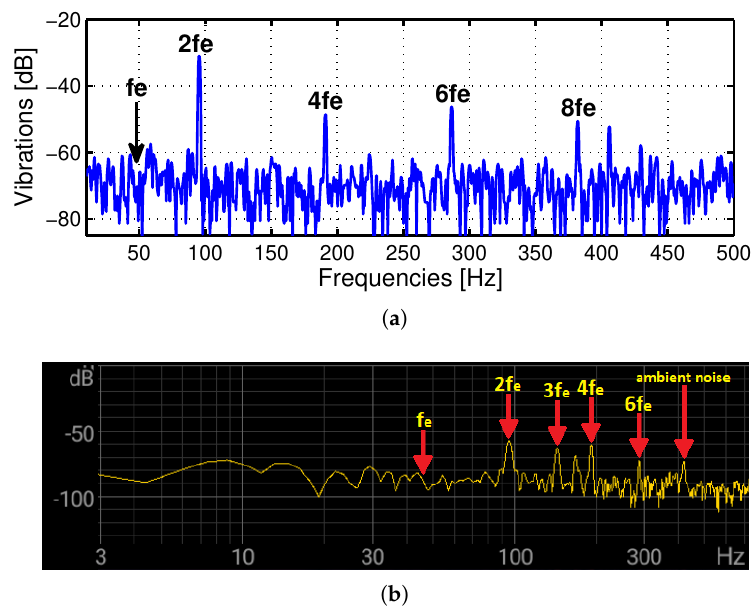
Figure 30. Cogging torque map OFF, CHC OFF, ω e = 300 rad